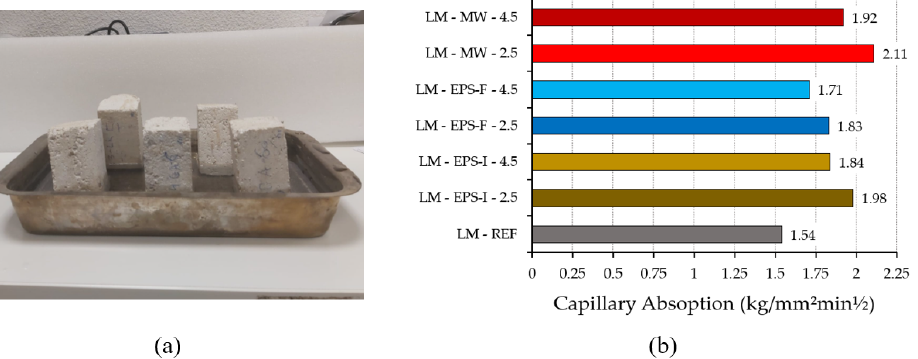
Figure 9. Water absorption by capillarity. ( a ) Standardized test according to UNE-EN 1015-18: 2003; ( b ) results obtained for the different absorption coefficients.